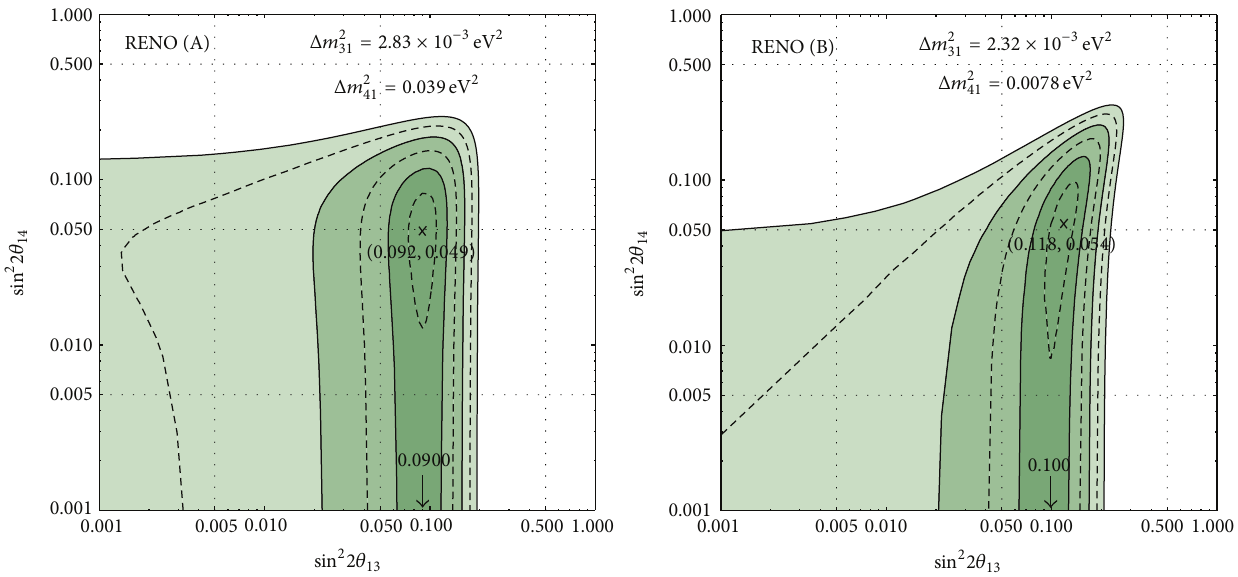
Figure 6: The 1𝜎, 2𝜎 , and 3𝜎 fit of combination of the sin 2 2𝜃 13 and sin 2 2𝜃 14 for chosen values of (Δ𝑚 2 31 and Δ𝑚 2 41 ) . For (A), the 𝜒 2 min / dof of / dof of (0.118, 0.049) is 0.96. In both cases, the best fit of sin 2 2𝜃 (0.092, 0.049) is 0.51. For (B), the 𝜒 2 min